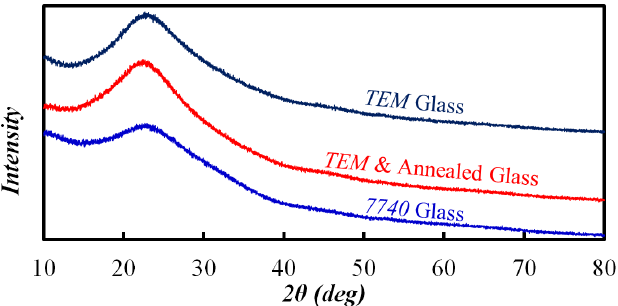
Figure 16. X-ray diffraction spectra of three glass.